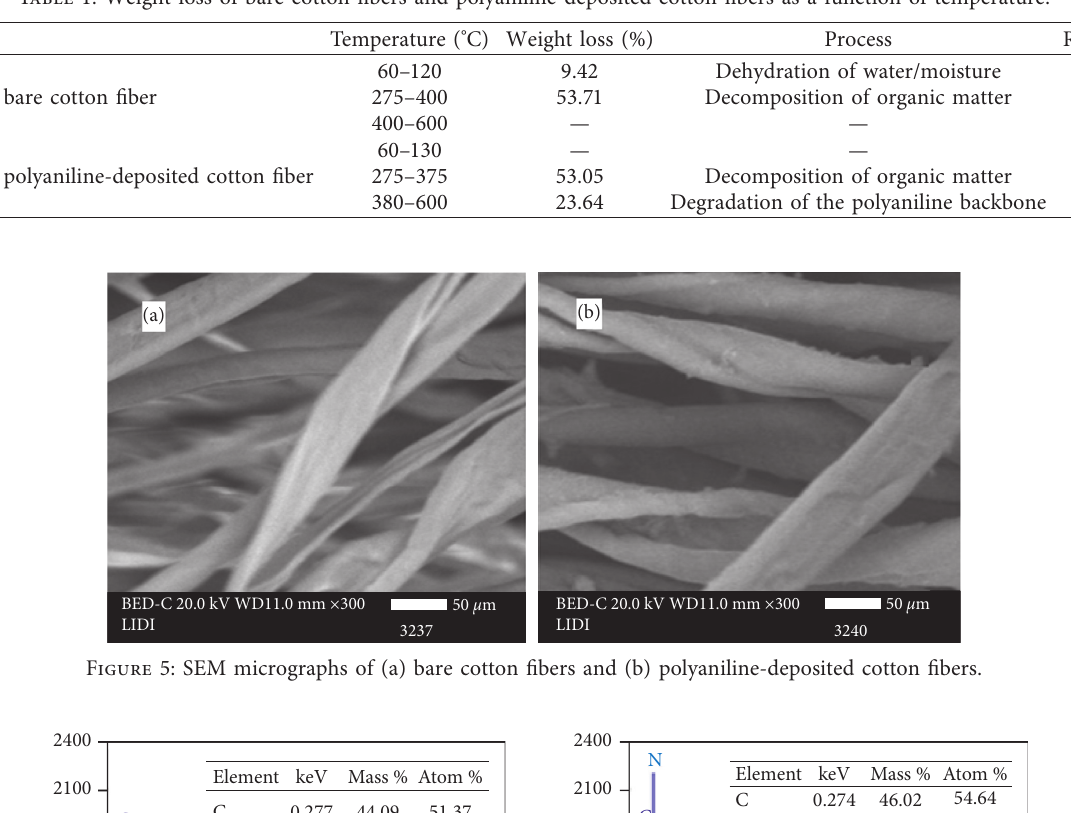
Table 1: Weight loss of bare cotton fibers and polyaniline-deposited cotton fibers as a function of temperature.